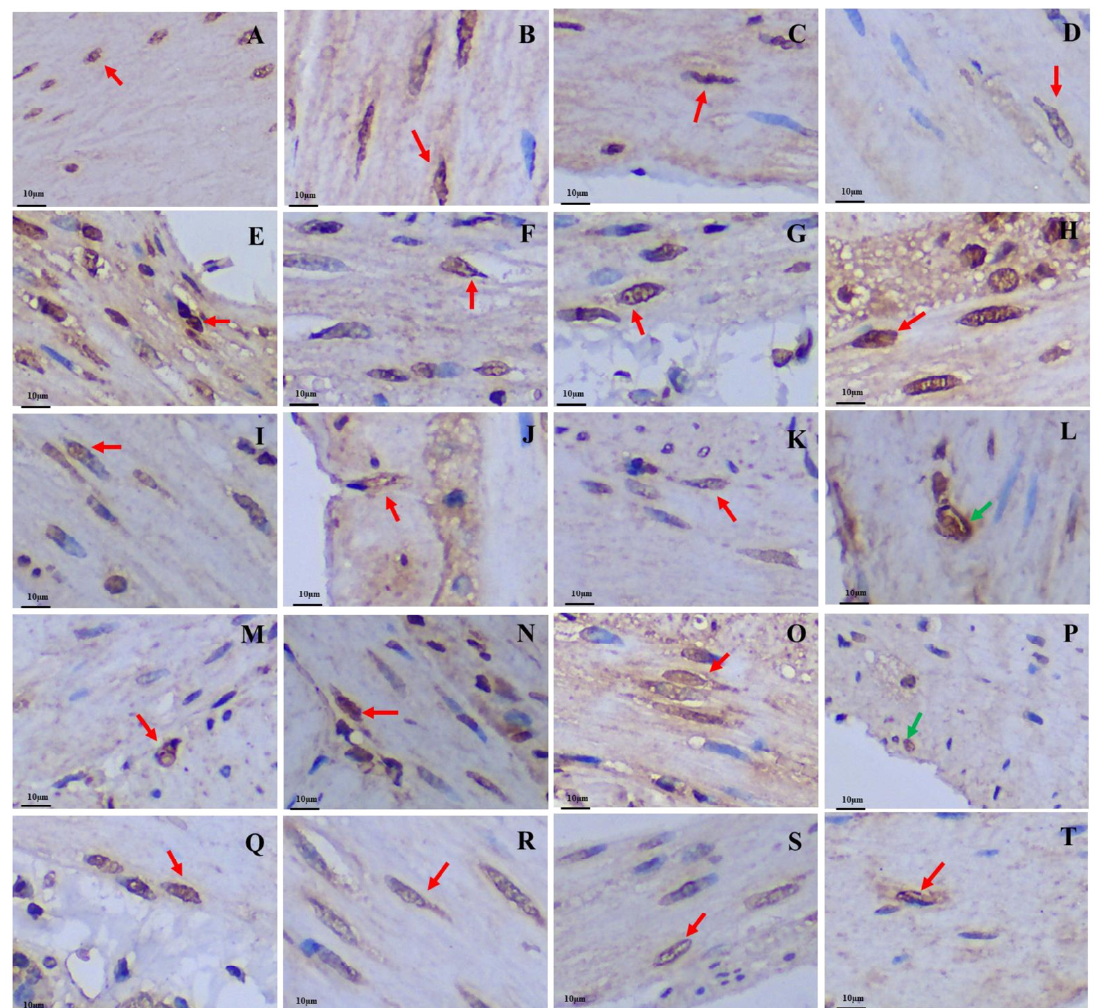
Figure 4. Distribution and morphology of 5-HT-immunoreactive cells in the GIT of the plateau zo- kor and plateau pika (400× magnification). ( A – J ) Followed by the fundus of stomach, corpus I of stomach, corpus II of stomach, pylorus of stomach, duodenum, jejunum, ileum, colon, rectum, and cecum of the plateau zokor; ( K – T ) similarly, the plateau pika’s gastrointestinal organs. The red ar- row indicates opened-type argyrophilic cells and the green arrow indicates closed-type argyrophilic cells.